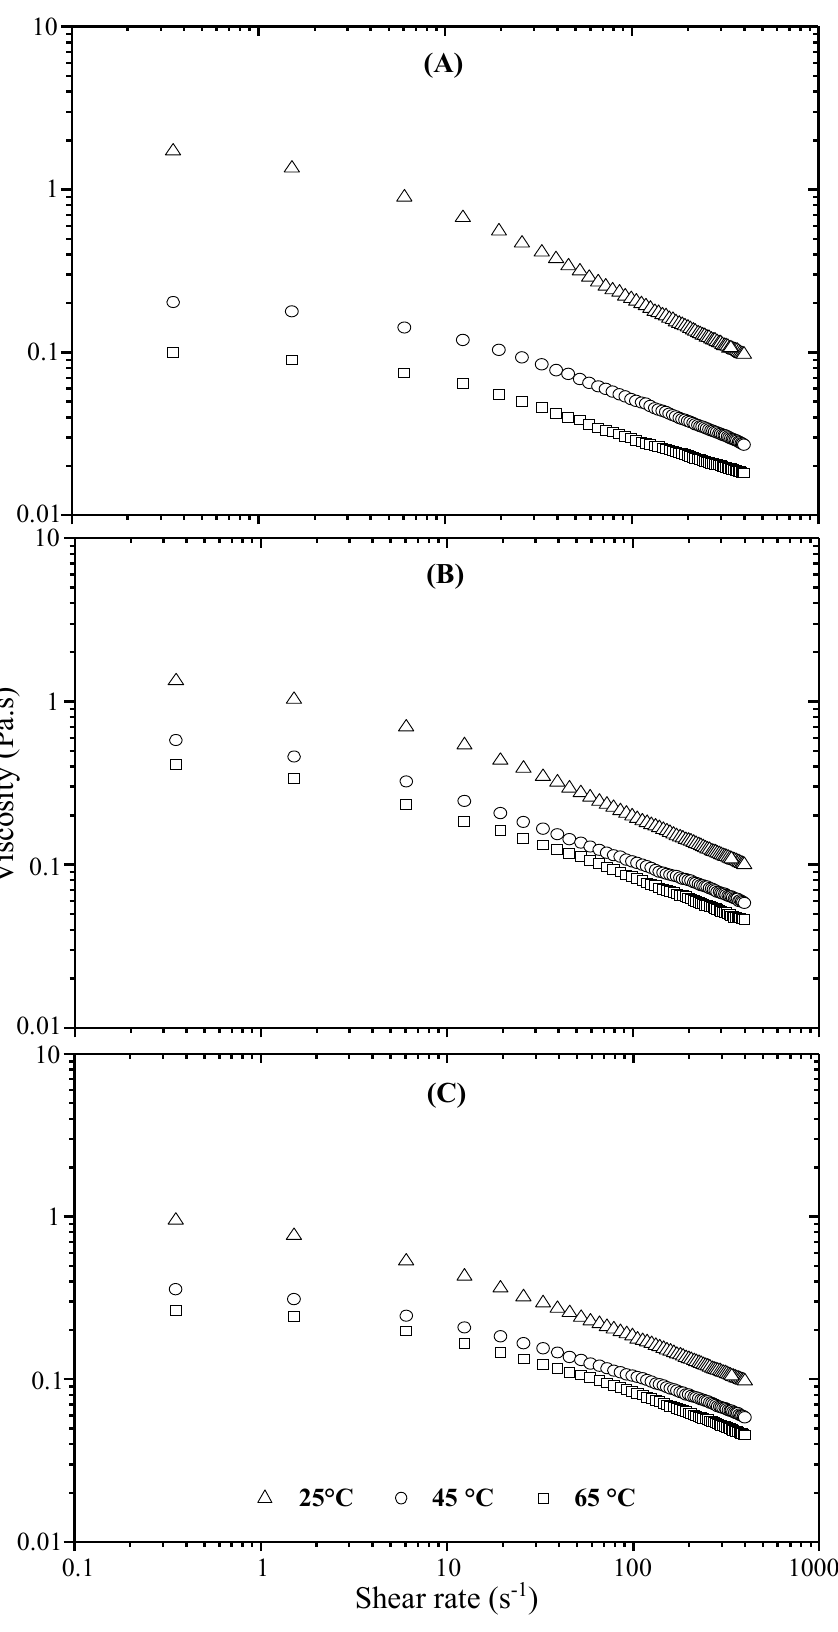
Figure 6. Influence of temperature on shear viscosity of grafted xanthan-DW ( A ), grafted xanthan-IW ( B ) and grafted xanthan-RW solutions ( C ).